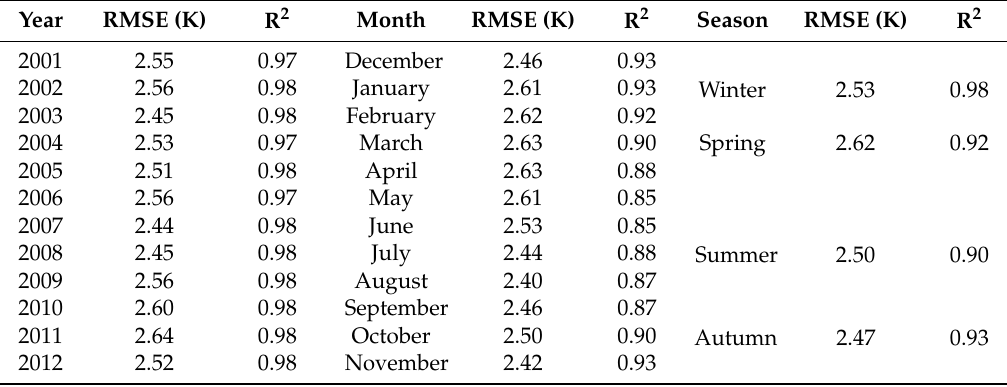
Table 2. Error between the estimated and the measured Ta sorted by year, season, and month.